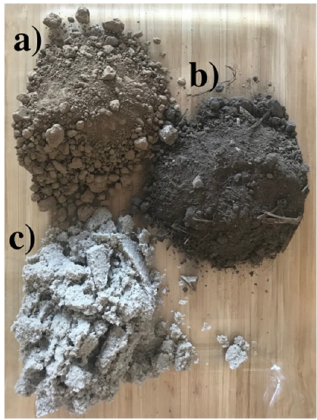
Figure 5. Tested soil types: ( a ) silt; ( b ) garden soil; ( c ) sand.